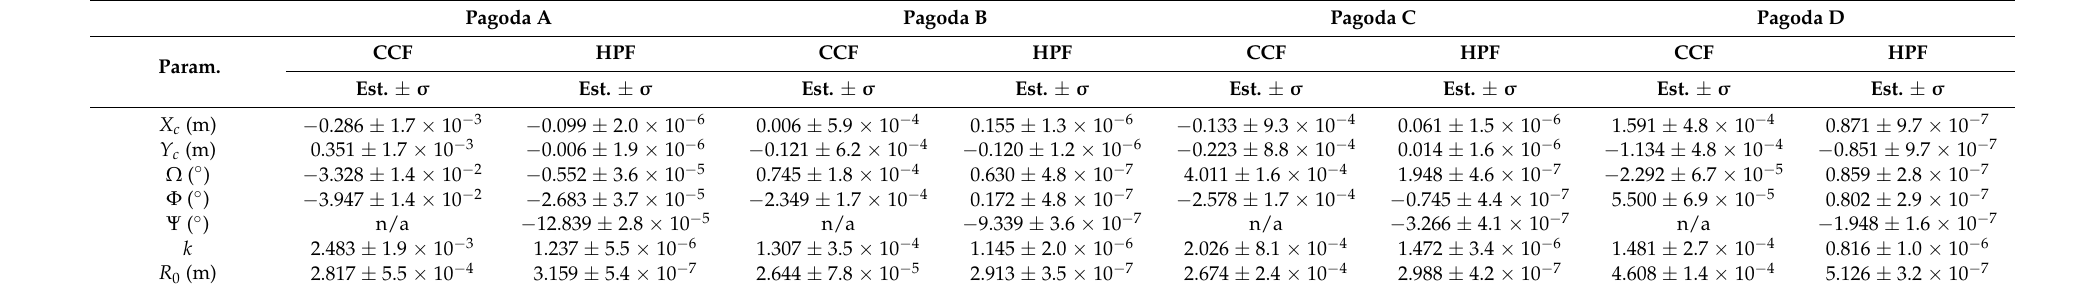
Table 3. Estimated parameters and their precisions of the CCF and the HPF for Part 2.